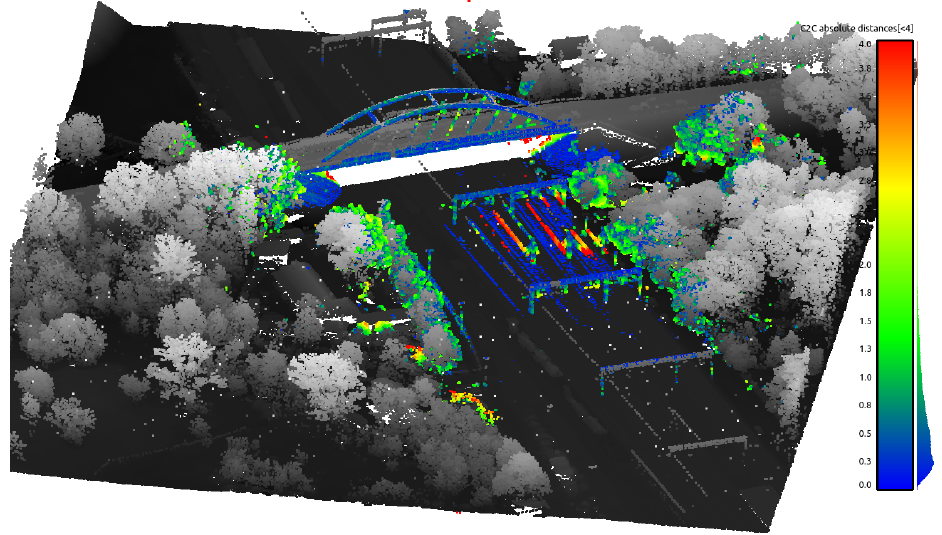
Figure 19. Comparison of scan obtained with designed system and DEM. DEM is given with gray scale; the obtained data from the system is given with color map. Color map encodes distance between measurement from our system and DEM.